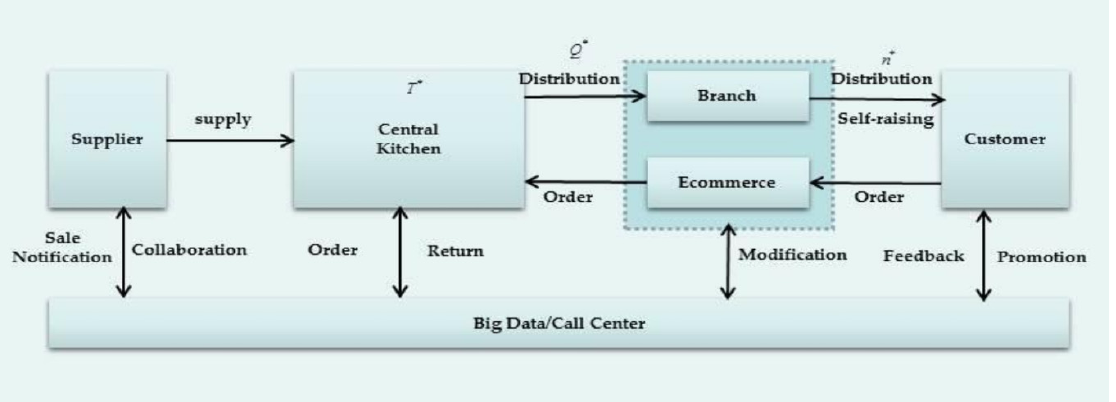
Figure 1. New retailing business model.